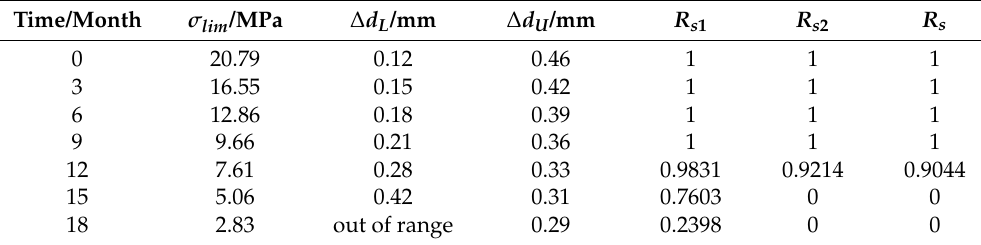
Table 3. Parameters at each time point of the